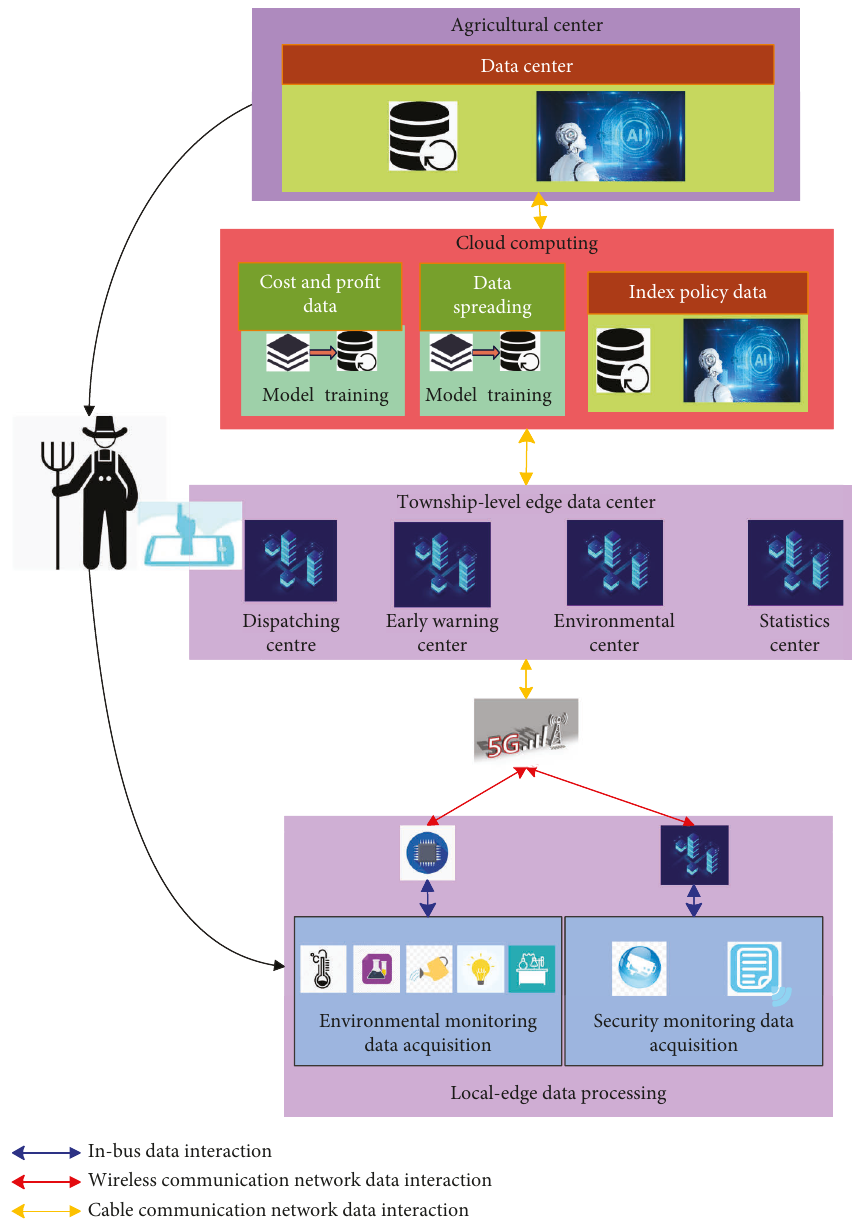
Figure 7: Schematic diagram of the process of edge computing in the application of smart